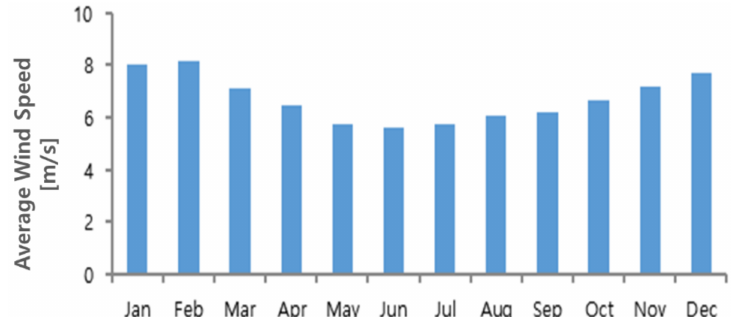
Figure 3. Monthly average wind speed.